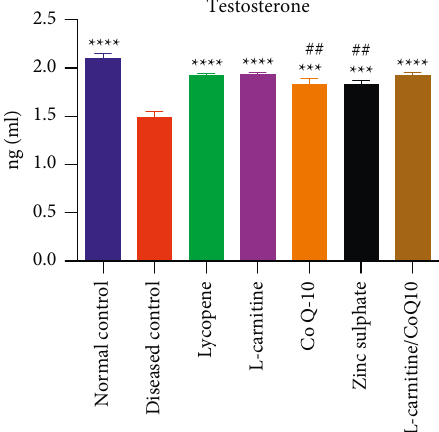
Figure 4: Effect of lycopene, L-carnitine, coenzyme Q10, and zinc sulfate on serum testosterone of cadmium-exposed